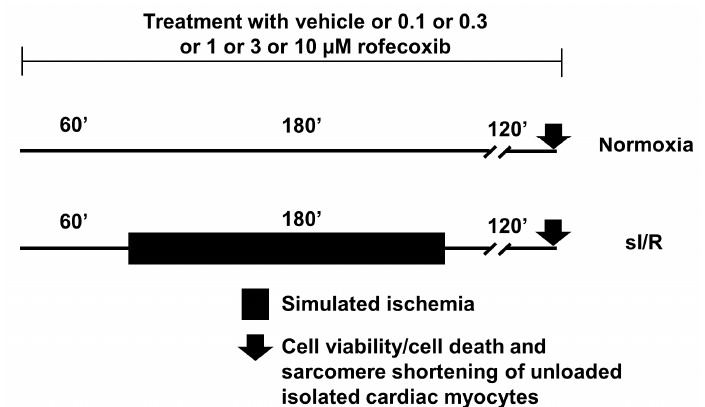
Figure 3. In vitro simulated ischemia / reperfusion (sI / R) injury study protocol: cell viability of cultured isolated cardiac myocytes was measured in normoxic and sI / R conditions in the presence of vehicle, 0.1, 0.3, 1, 3, or 10 µ M rofecoxib, respectively.